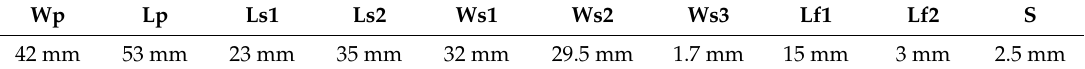
Table 1. Design parameters of the patch antenna.